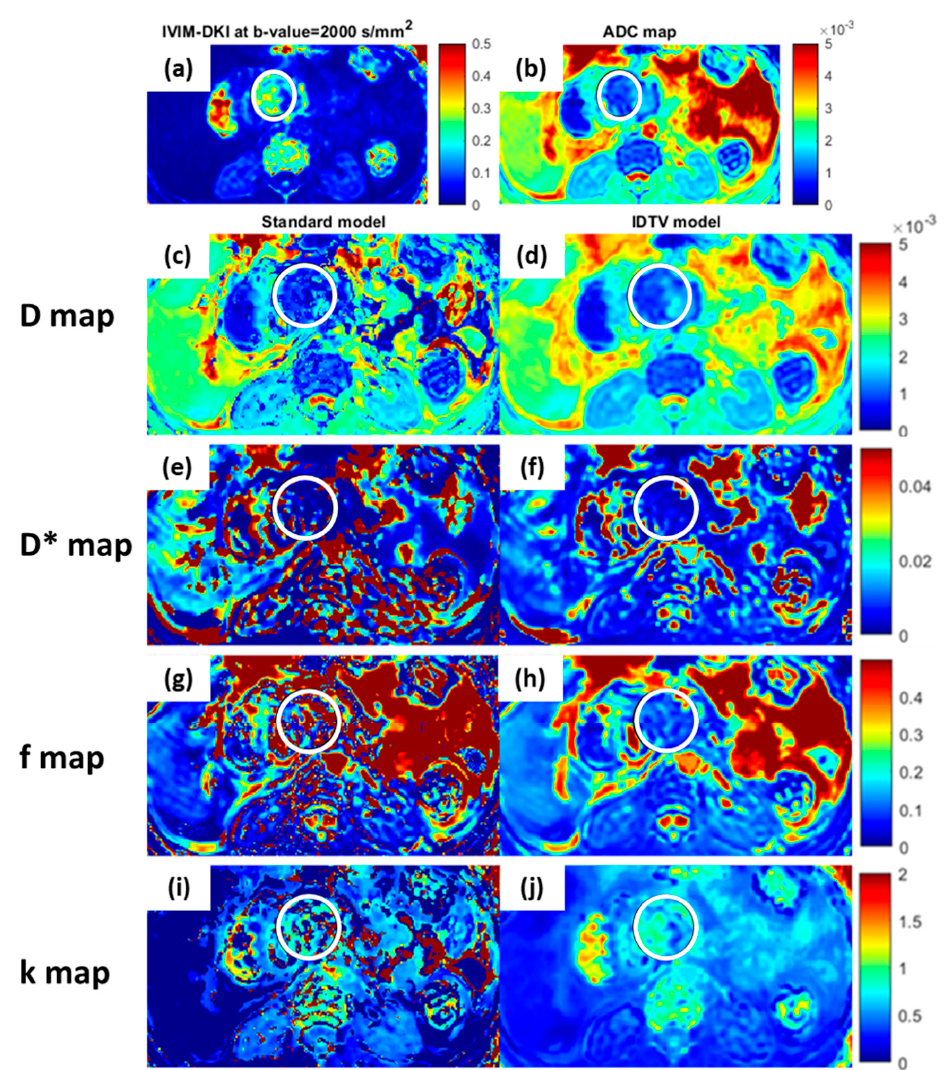
Figure 4. Representative image of a 53-year-old male patient with pancreatic ductal adenocarci- noma (PDAC) demonstrating qualitative comparison between parametric maps estimated using standard ( c , e , g , i ) and IDTV ( d , f , h , j ) models. The encircled zone (white) represents the tumor, and the IDTV model successfully eliminated noise from the parametric maps when compared to the standard model. ( a ) IVIM-DKI image at b = 2000 mm 2 /s appears hyperintense in encircled region and ( b ) hypointense in corresponding region in ADC map. ( j ) In k map, hyperintensity was seen in the tumor region, while ( d , f , h ) hypointensity was observed in the D, D*, and f maps. ( c , d ) D map, ( e , f ) D*map, ( g , h ) f map, and ( i , j ) k